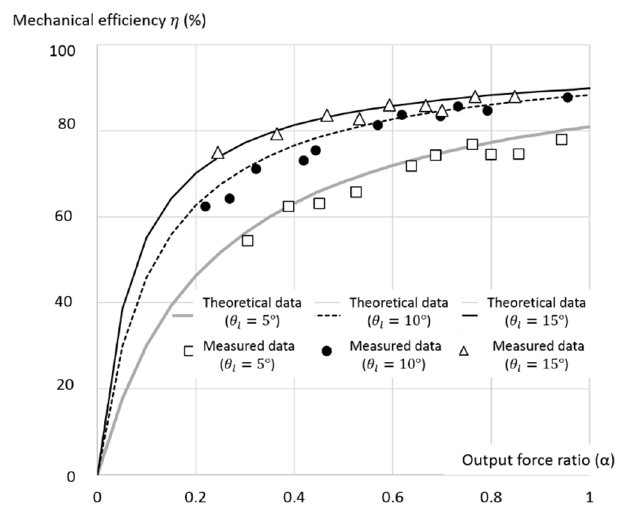
Figure 12. The theoretical and measured mechanical efficiency under different output force ratio with lead angle of 5 degrees, 10 degrees and 15 degrees.